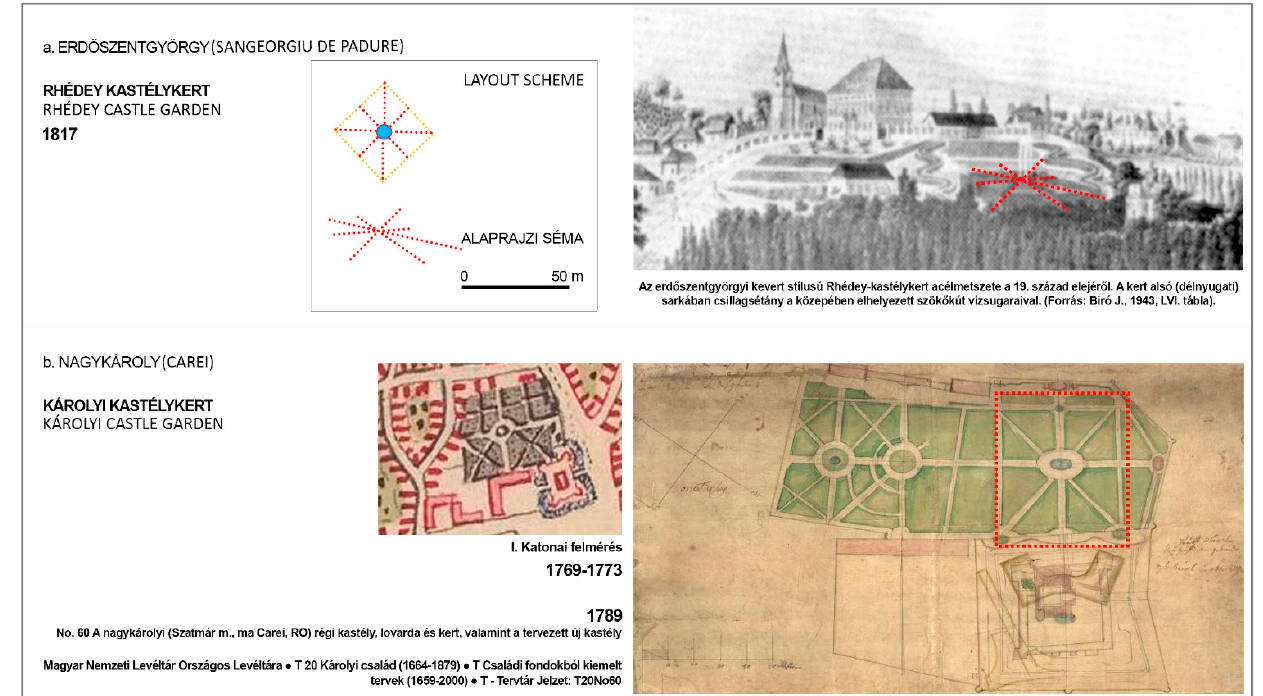
Figure 7. Source: compiled by Albert Fekete. ( a ). Steel engraving of the Rhédey castle garden in Erd˝oszentgyörgy from 1817 [47]. ( b ). Franz Rosenstingl’s 1789 plan of the castle garden in Nagykároly (Carei, RO) based on “A nagykárolyi (Szatmár m., ma Carei, RO) régi kastély, lovarda és kert, valamint a tervezett új kastély” [71].